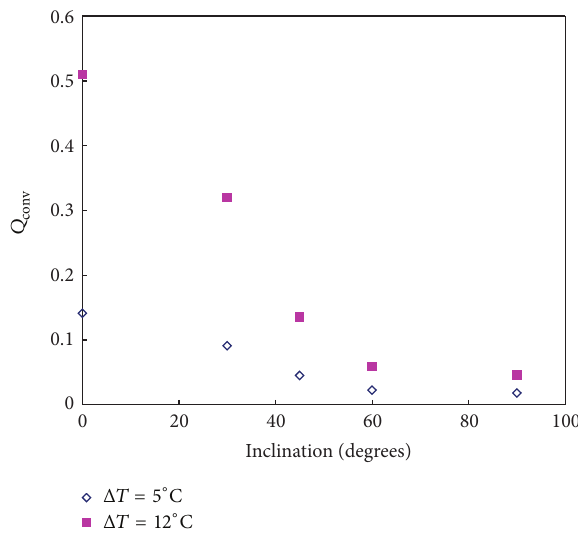
Figure 4: Variation of the convective loss (in Watts) with Δ𝑇 and inclination for open cubical cavity of side